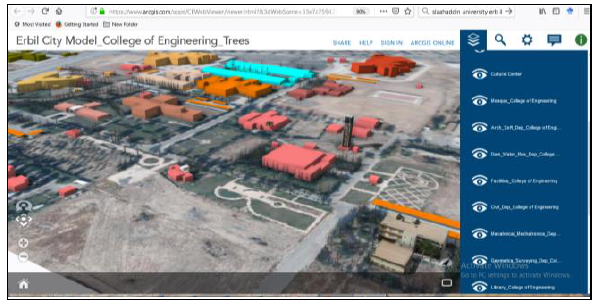
Figure 8. Online publishing of the 3D city model obtained via stereo aerial Figure 6. Two different complex buildings that are specified to be multi-layered and were produced using summit evolution software